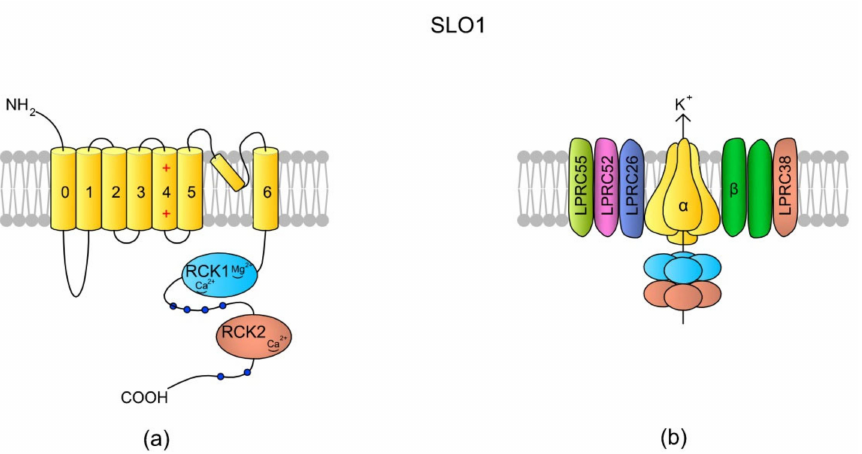
Figure 5. SLO1 structure scheme. ( a ) A topology of the α subunit. Each α subunit consists of seven (0–6) TMs, where TM4 is a typical voltage-sensing domain (VSD). An extracellular loop between TM5 and TM6 forms the pore. The N-tail is located extracellularly but the C-end is a long tail containing the RCK1 (regulator of K + conductance 1) and RKC2 domains [135]. The structural difference between SLO1 and SLO3 is that there are “Ca 2+ -bowl” structures within the RKC domains of SLO1, making the channel sensitive to [Ca 2+ ] i . ( b ) In the tetrameric structure of the channel, the cytoplasmic C-termini creates a gating ring. According to the literature, SLO1 has five auxiliary subunits: one β subunit (with two transmembrane domains) and four Leucine-rich repeat-containing membrane proteins (LRRCs, also named γ subunits), LRRC26, LRCC52, LRRC55, and LRRC38, which modulate SLO1 sensitivity to Vm and [Ca 2+ ] i (revised by Reference [144]). In murine testes and spermatozoa, two auxiliary subunits of the SLO3 channel have been identified: Lrrc52 and Lrrc26. Both of them are involved in the regulation of SLO3, and the expression of Lrrc52 is critically dependent on the presence of SLO3 [143]. The schemes are adapted from References